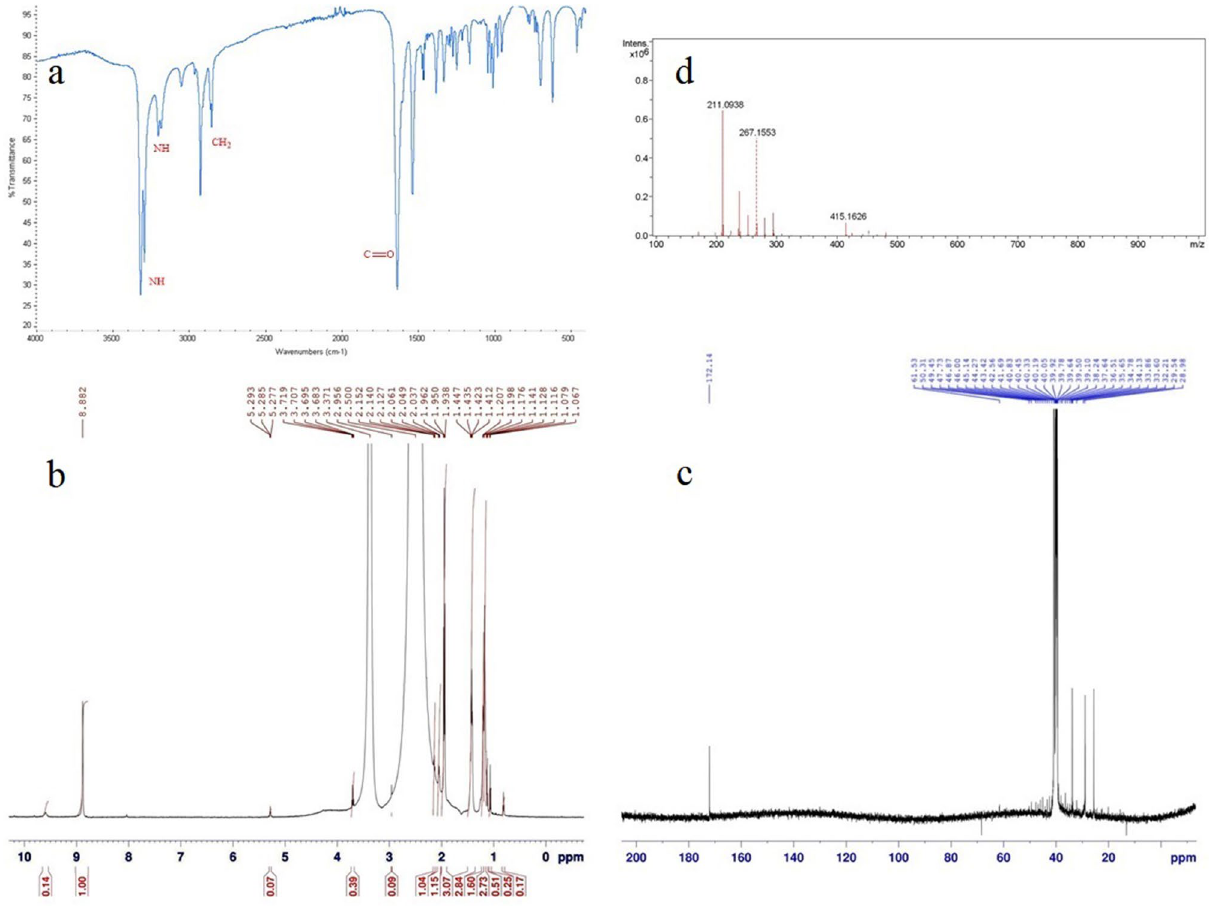
Figure 2. ( a ) FTIR; ( b ) Proton NMR; ( c ) Carbon- 13 NMR and ( d ) Mass spectra of